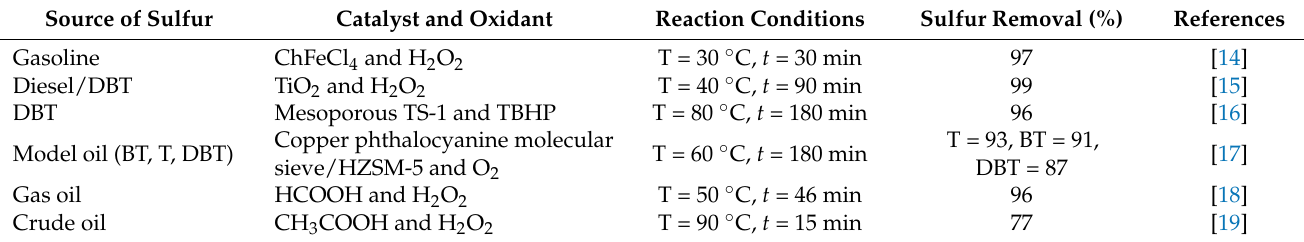
Table 1. Oxidative desulfurization of petroleum fuels and model sulfur compounds.